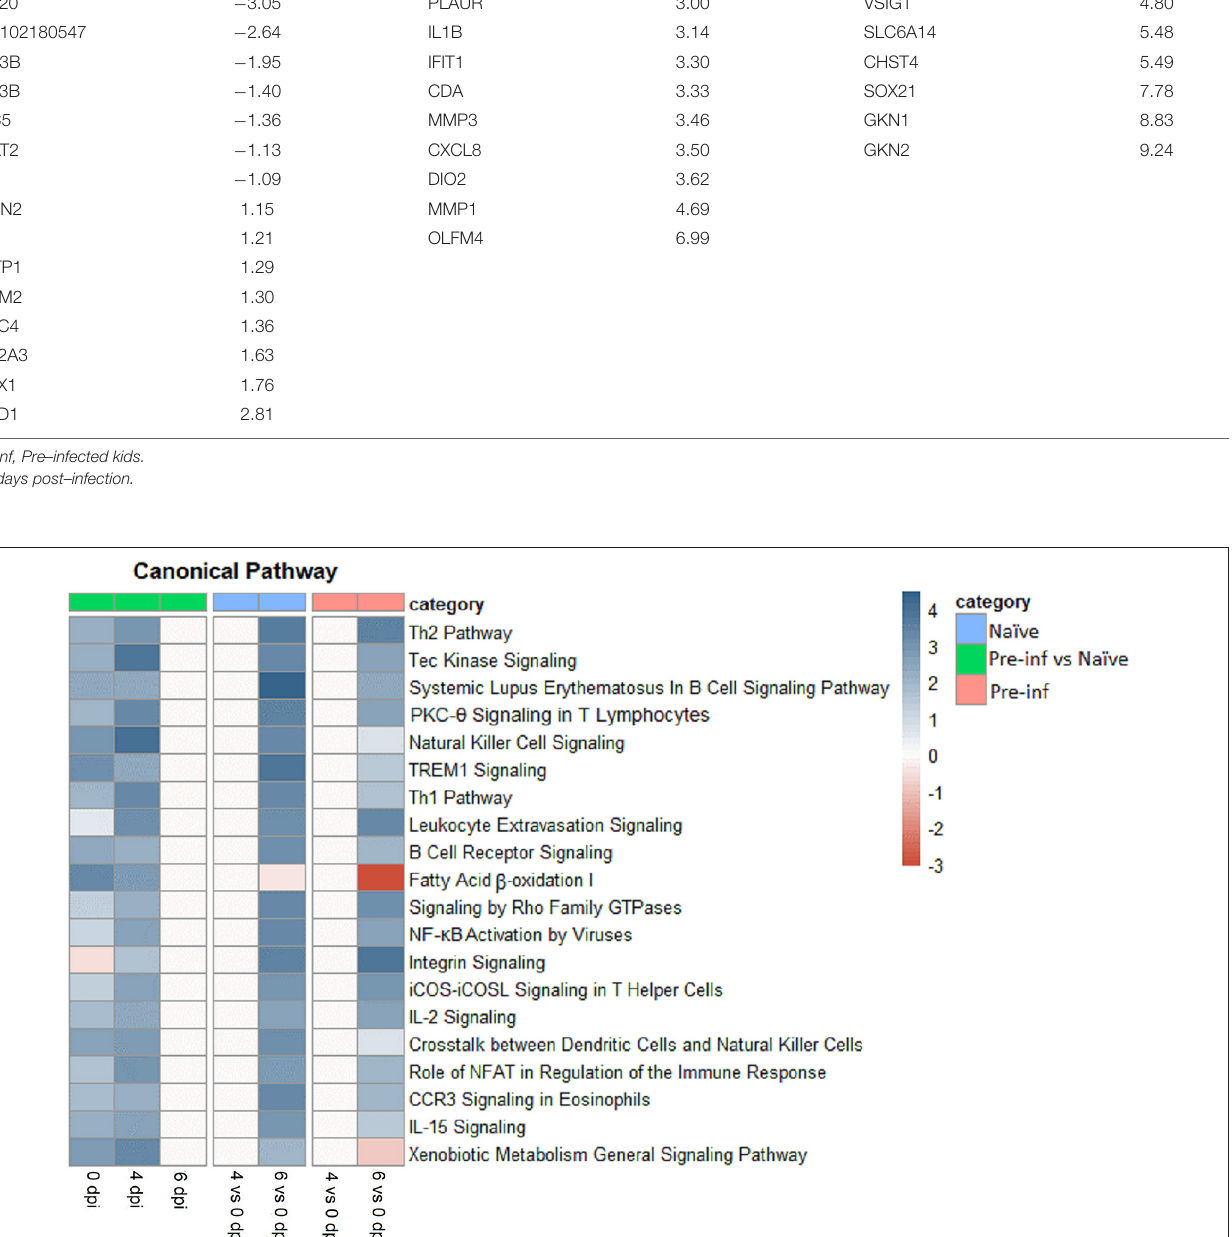
Frontiers in Veterinary Science |